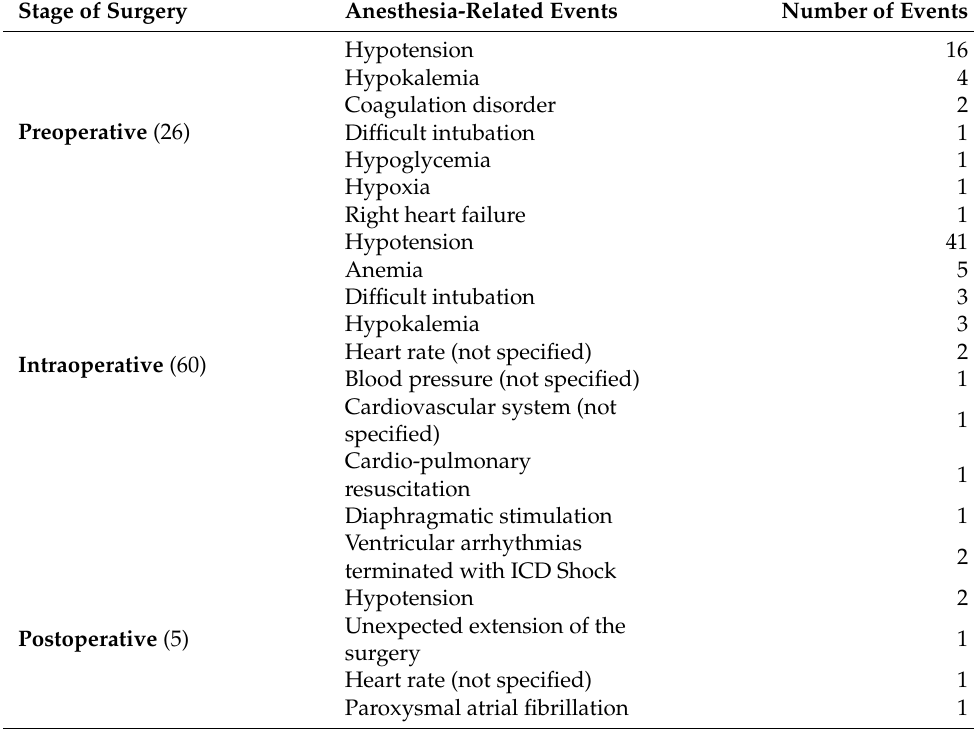
Table 7. Anesthesia-related events.